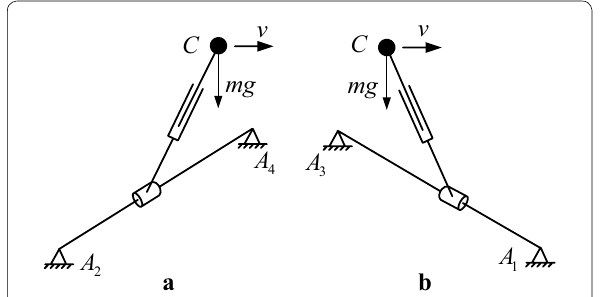
Figure 14 Simplified mechanism of robot in trotting